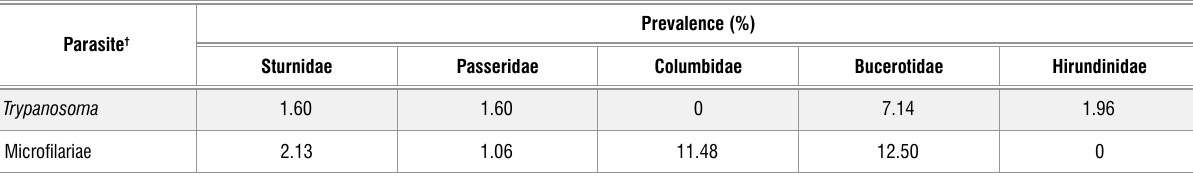
Prevalence of parasites according to Aves families. Only bird families from which more than 50 individuals were examined are included here.